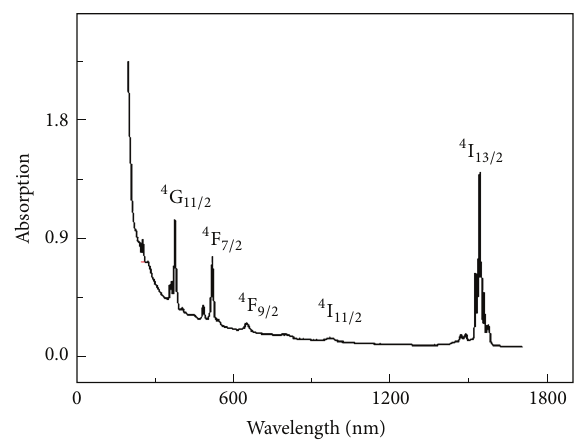
Figure1:TheabsorptionspectraofEBBOcrystal.Thisfigureisfrom [23] with